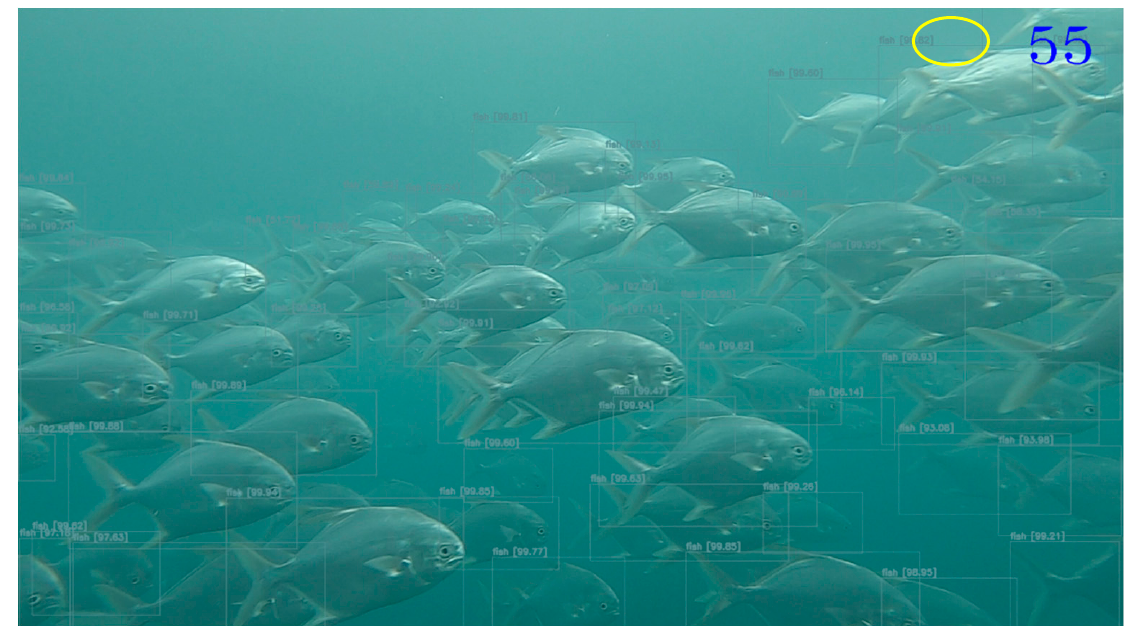
Figure 28. Stereo camera system trachinotus blochii species count estimation.